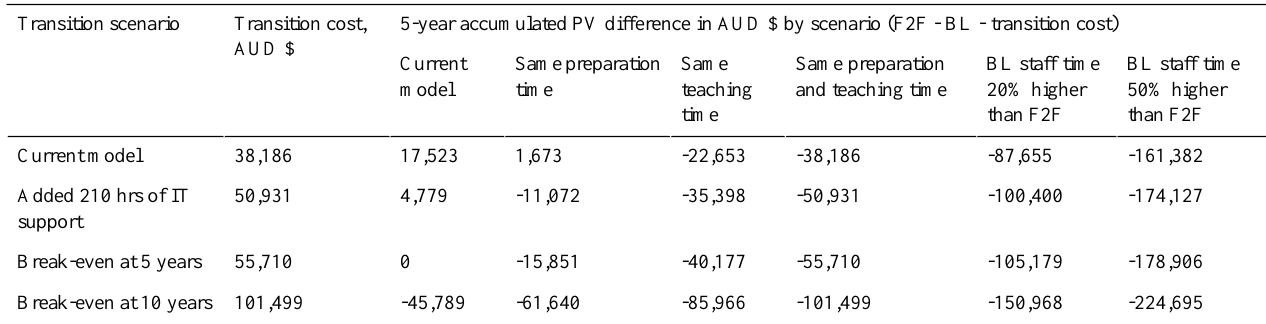
Table 5. Multivariate sensitivity analysis adjusting transition costs and ongoing cost